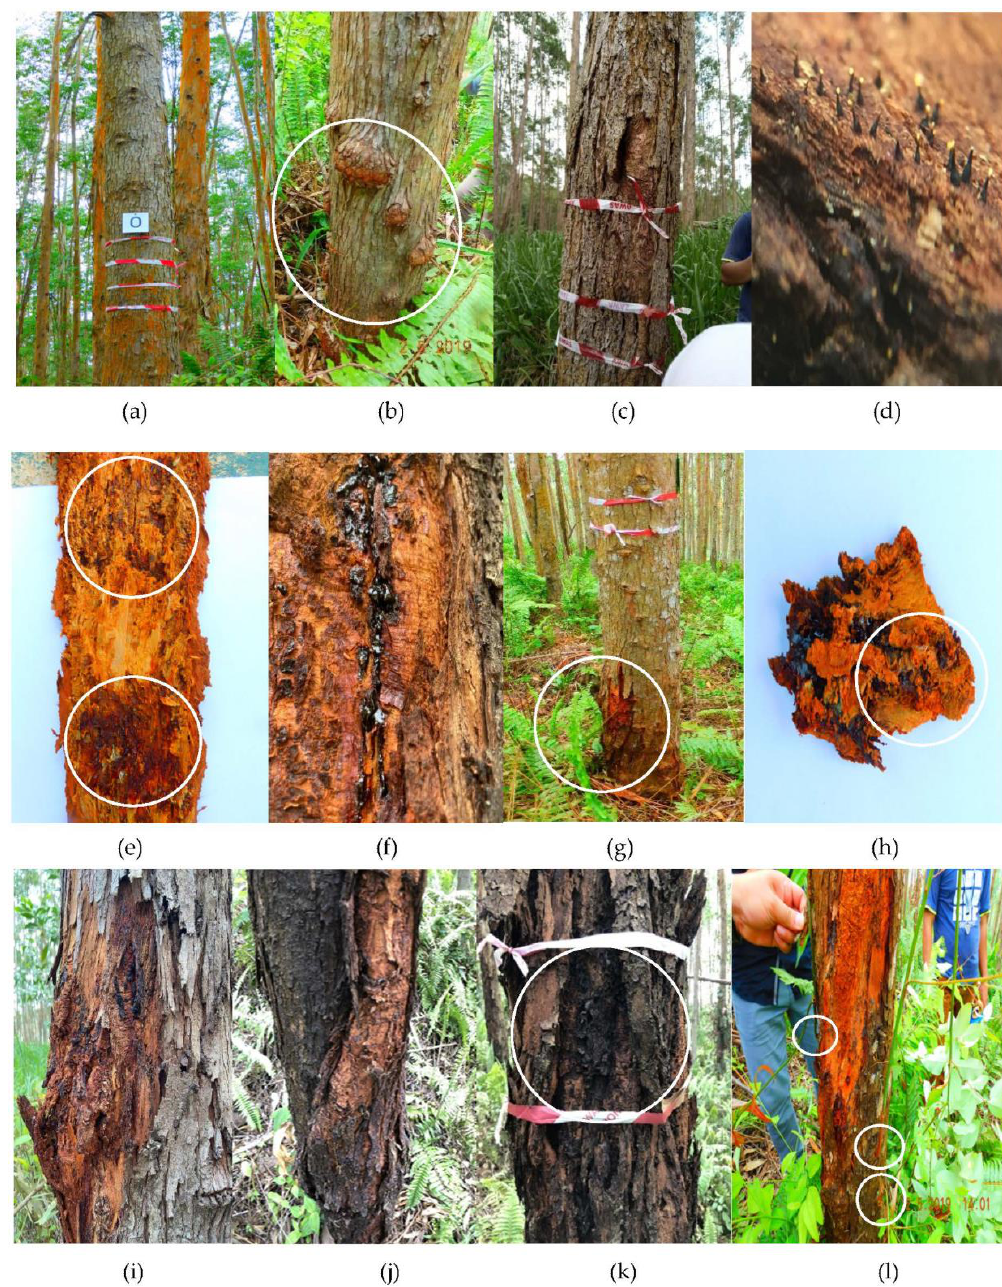
Figure 1. Symptoms of Cryphonectria deuterocubensis on E. urograndis ; ( a ) healthy tree, absence of any symptom; ( b ) swollen/callus, the reaction from the infected trees can be observed by the form of callus around the site of infection, leading to the bulging of the outer layer of bark; ( c ) cracking, by the shredding of outer layer bark, and these swollen/callus may coalesce to form a larger crack; ( d ) fruiting structure, stromata harbouring the fruiting bodies of C. deuterocubensis may develop in the bark and cambium of the cankers which are a clear sign of a E. urograndis infection; ( e , h ) kino pocket, due to injury of the cambium which resulting in the formation of kino pocket under the bark of infected stem; ( g ) canker, C. deuterocubensis causes perennial necrotic lesions (cankers) on the bark of stems are orange to reddish-brown on the surface; ( f , i ) fresh and dried kino/gummosis, as a defense response by the tree to infection of fungal disease, leads to abundant kino exudation produced from the secretory cells in the tree; ( j ) sunken, when the cambium is killed, the bark sinks inwards, giving the canker a characteristic sunken appearance; ( k ) rotten, decayed and brittle texture near the canker area due to repeated infections for a long period of time; ( l ) epicormic shoots, observed below the canker area as trees regrow after coppicing or